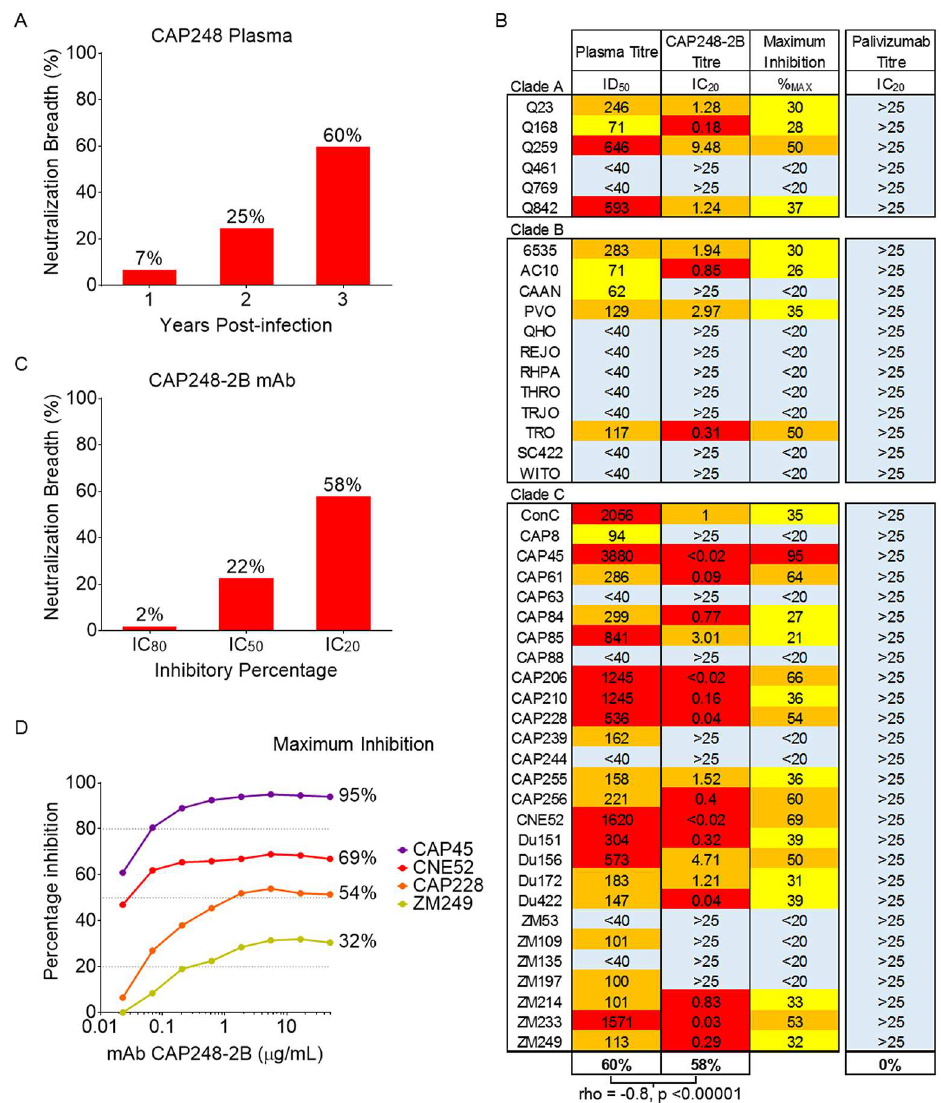
Fig 1. Isolated antibody CAP248-2Bexhibits low neutralization plateaus, but recapitulates the plasma neutralization breadth. (A) Bar graph showingpercentageneutralization breadth of CAP248plasma at ID 50 titers of > 1:100(y-axis) on a 45 virus panel at one, two, and three years post-infection (x-axis). The total breadth at each time point is indicatedabove the bars. (B) Comparison between the neutralizationbreadth of CAP248plasma at three years, and CAP248-2Bat IC 20 . The maximum percentageneutralization (neutralization plateau)reachedby CAP248-2B is indicated. Palivizumab, a monoclonal antibodyspecific for Respiratory Syncytial Virus (RSV), was used as an IC 20 negativecontrol. Titers are colored yellow, orange and red by potency. A strong inversespearman correlation with a rho value of -0.802 (p-value < 0.00001) indicatesgood concordance betweenCAP248plasma ID 50 and CAP248-2B monoclonal antibody IC 20 . (C) Percentage neutralizationbreadth of monoclonal antibody CAP248-2B (y-axis) on the same 45 virus panel as in A, when measuredat IC 80 , IC 50 , and IC 20 (x-axis). (D) Neutralization curves of CAP248-2B against four viral strains (CAP45, CNE52, CAP228, and ZM249) plotted as percentage inhibition(y-axis) versus antibody concentration (x-axis). Dotted lines indicatey-axis intersections for IC 80 , IC 50 , and IC 20 . The maximum inhibitorypercentage achievedagainsteach virus is listed to the right of each curve.